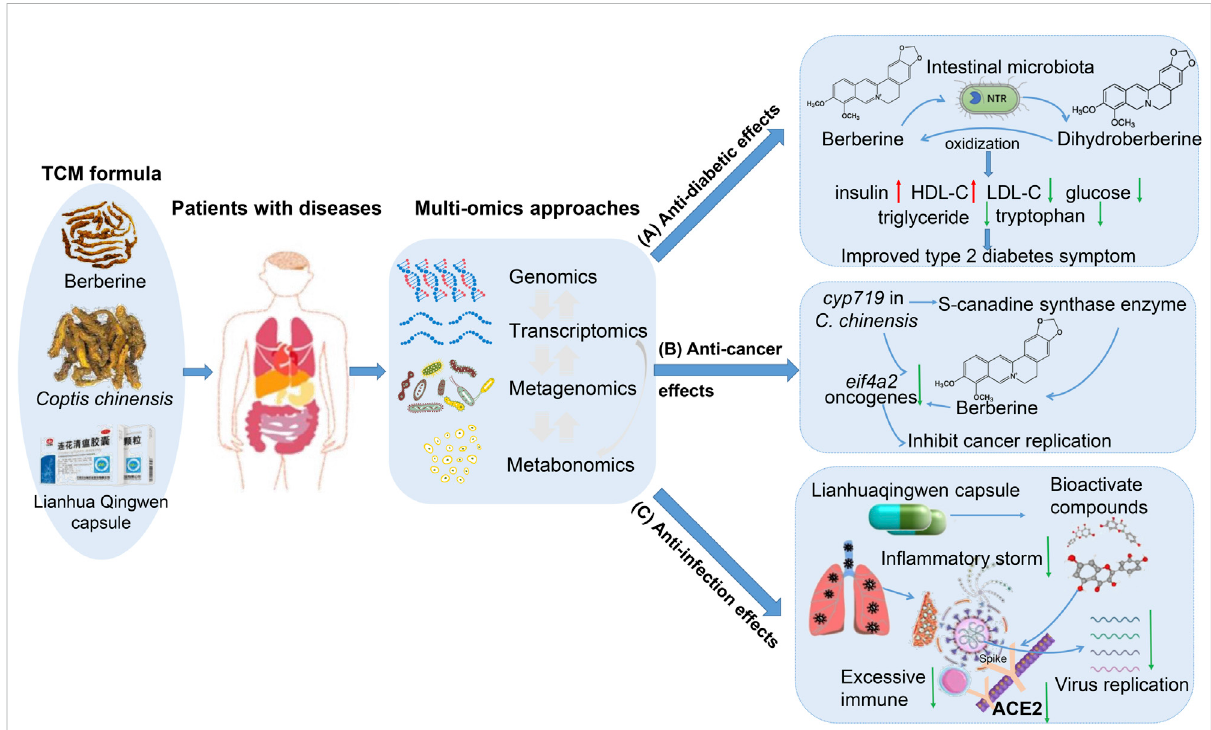
FIGURE 2 Multi-omics approaches are applicable for investigating the therapeutic mechanism of TCM in treating diseases. In this review, we used berberine, C.chinensis Franch.(Ranunculaceae),andLianhuaqingwencapuseasexamplestoillustratethecriticalroleofmulti-omicsapproachesin elucidatingthetherapeuticmechanismofTCM. (A) Multi-omicsanalysisforberberineintreatingtype2diabetesmellitus.Inthiscasestudy,intestinal microbes converted berberine as host absorbable molecule dihydroberberine to improve diabetes. NTR: nitroreductase. (B) Multi-omics analysis of C . chinensis Franch. (Ranunculaceae) for anti-cancer effect. Through multi-omics analysis, the functional genes (i.e., cyp719 ) and bioactivecompounds(i.e.,berberine)of C.chinensis